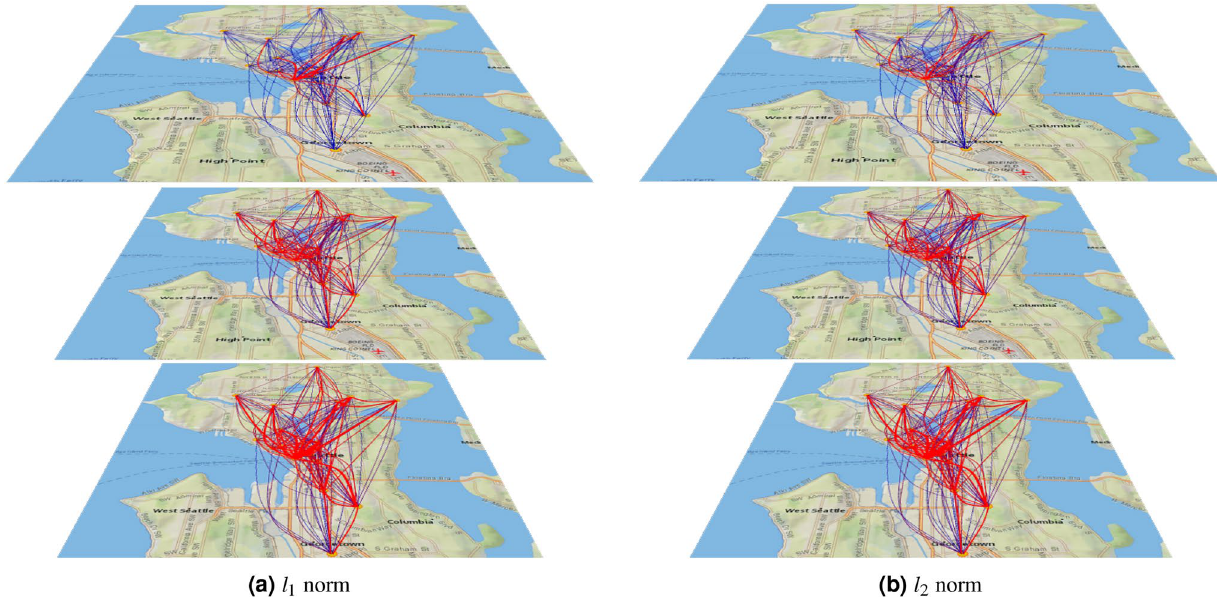
Figure 5. Comparison of the optimal prevention in the 20-node model of the Seattle city, correspondent to Eq. (7) with k = 1 , computed for a particular instance of J ( reduced) under l 1 (left sub-figure) and l 2 (right sub-figure). In each sub-graph initial instance, J ( correction, layers respectively. Wider lines and red colors (in the red-to-dark blue color-coding) correspond to pair-wise links with higher values of J . (The Unfolding 42 and Processing 43 software was used to create the